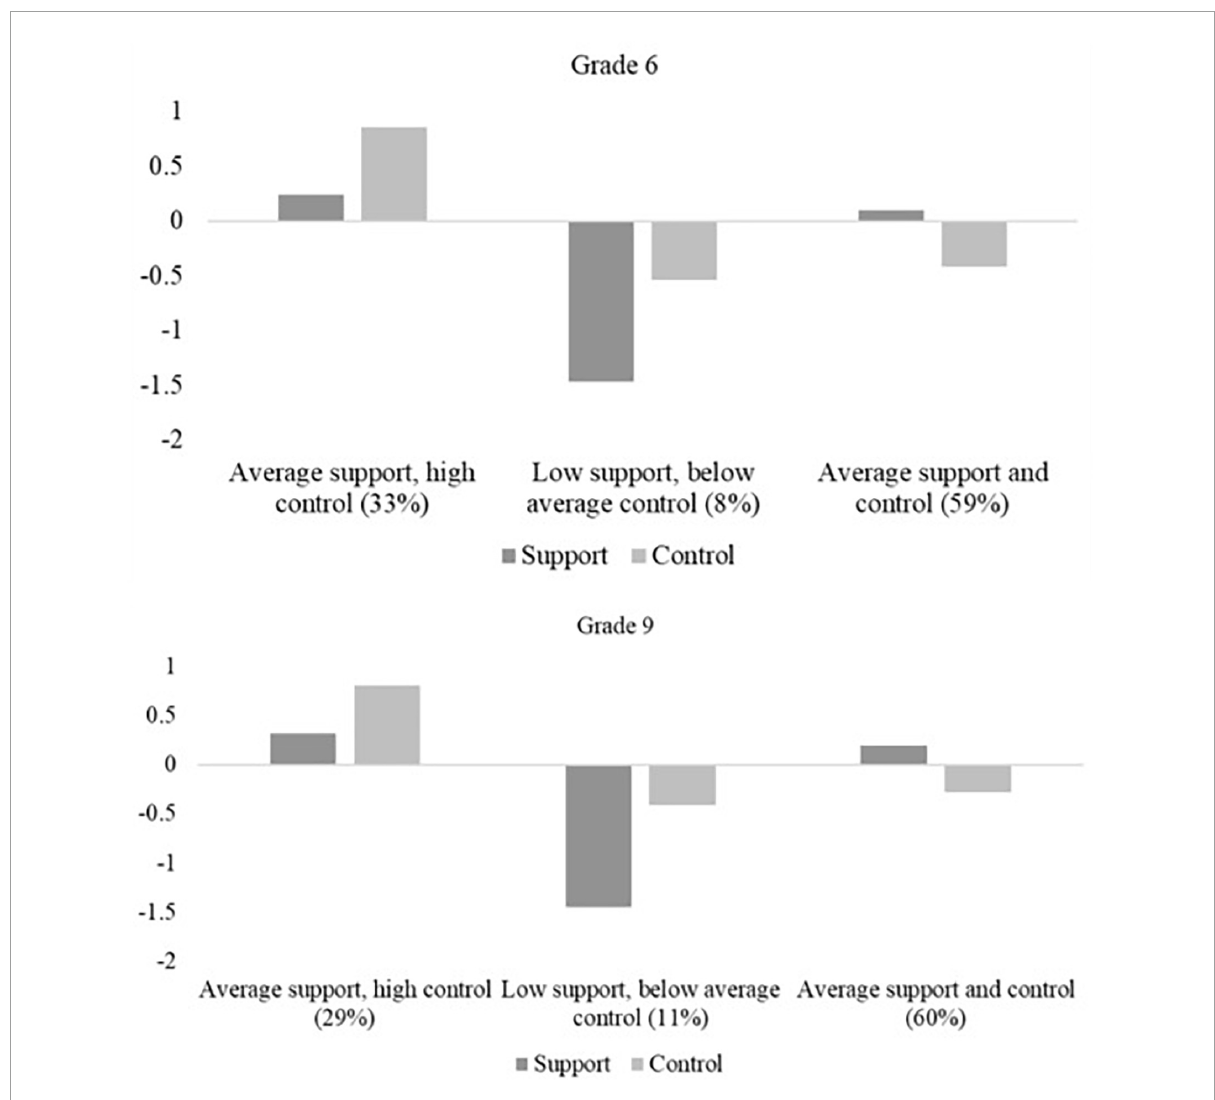
FIGURE1 Standardized means of the latent parental-help profiles in grades 6 and